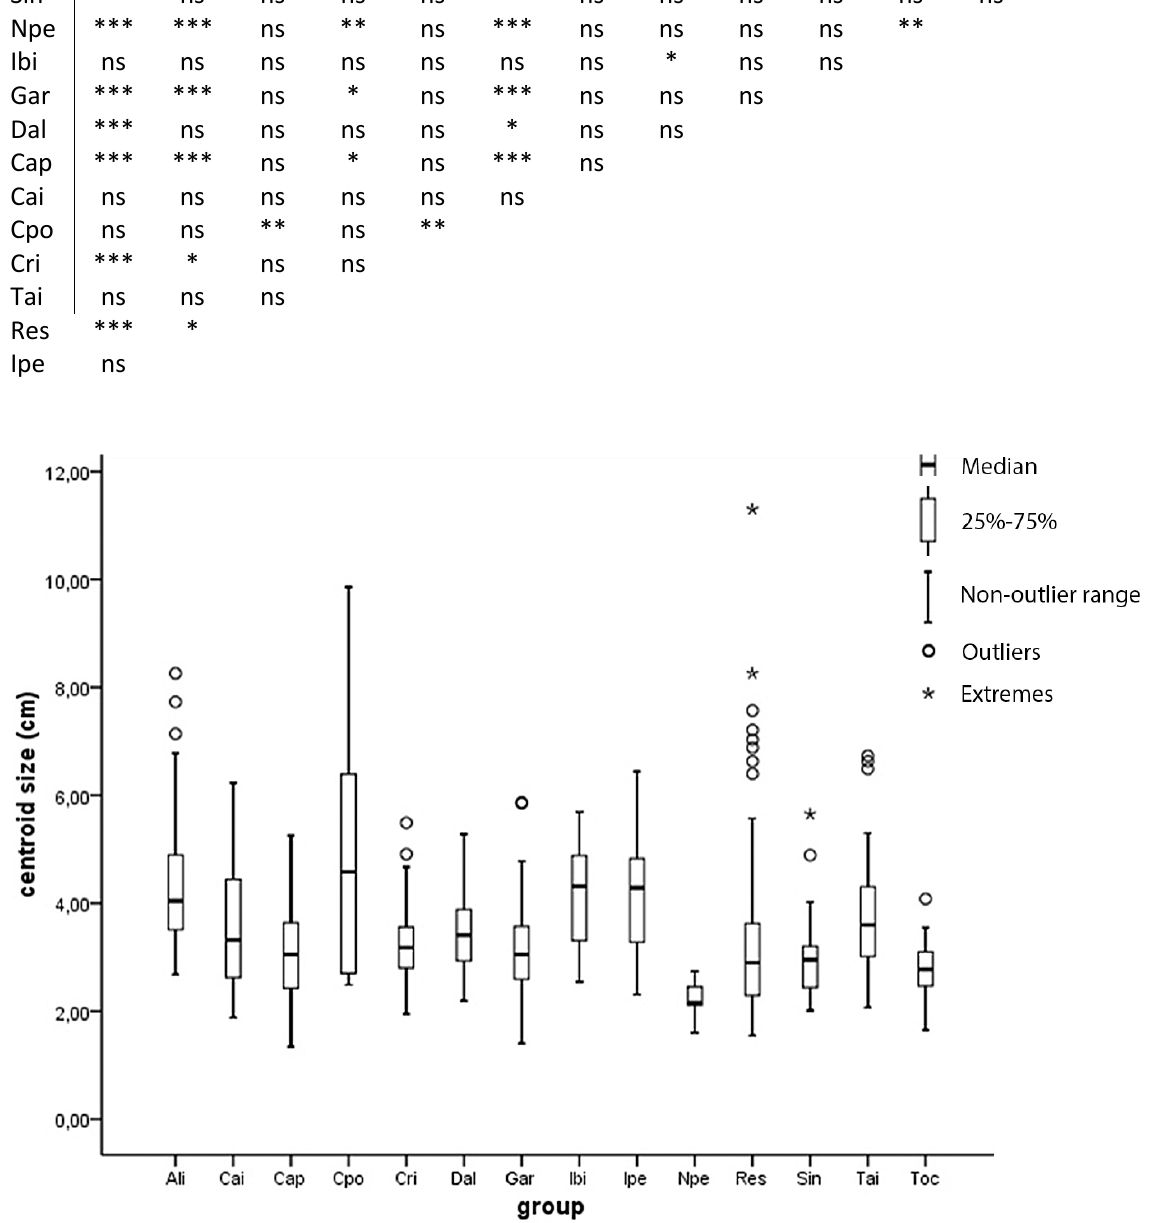
Figure 4: Box-plot graphs based on centroid